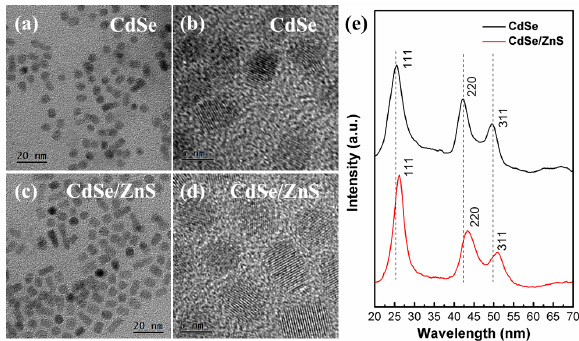
Figure 1: HRTEM image of as-prepared (a), (b) CdSe QDs, (c), (d) CdSe/ZnS QDs and (e) consequent XRD pattern on high resolution images. HRTEM: high resolution transmission electron microscope; XRD: X-ray diffraction.